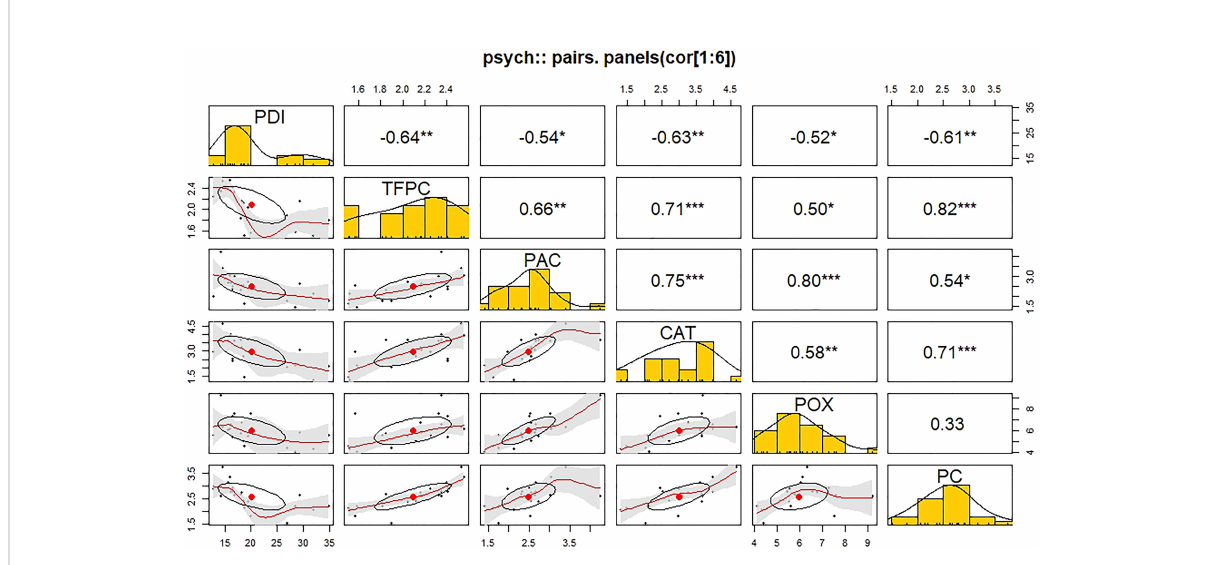
FIGURE 8 Correlation matrix (Pearson ’ s method) of different biochemical parameters in response to Stemphylium vesicarium